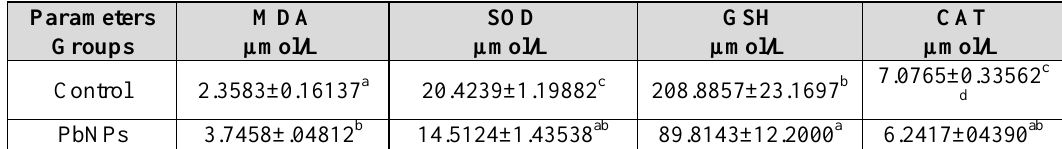
Table 3: Effects of PbNPs on